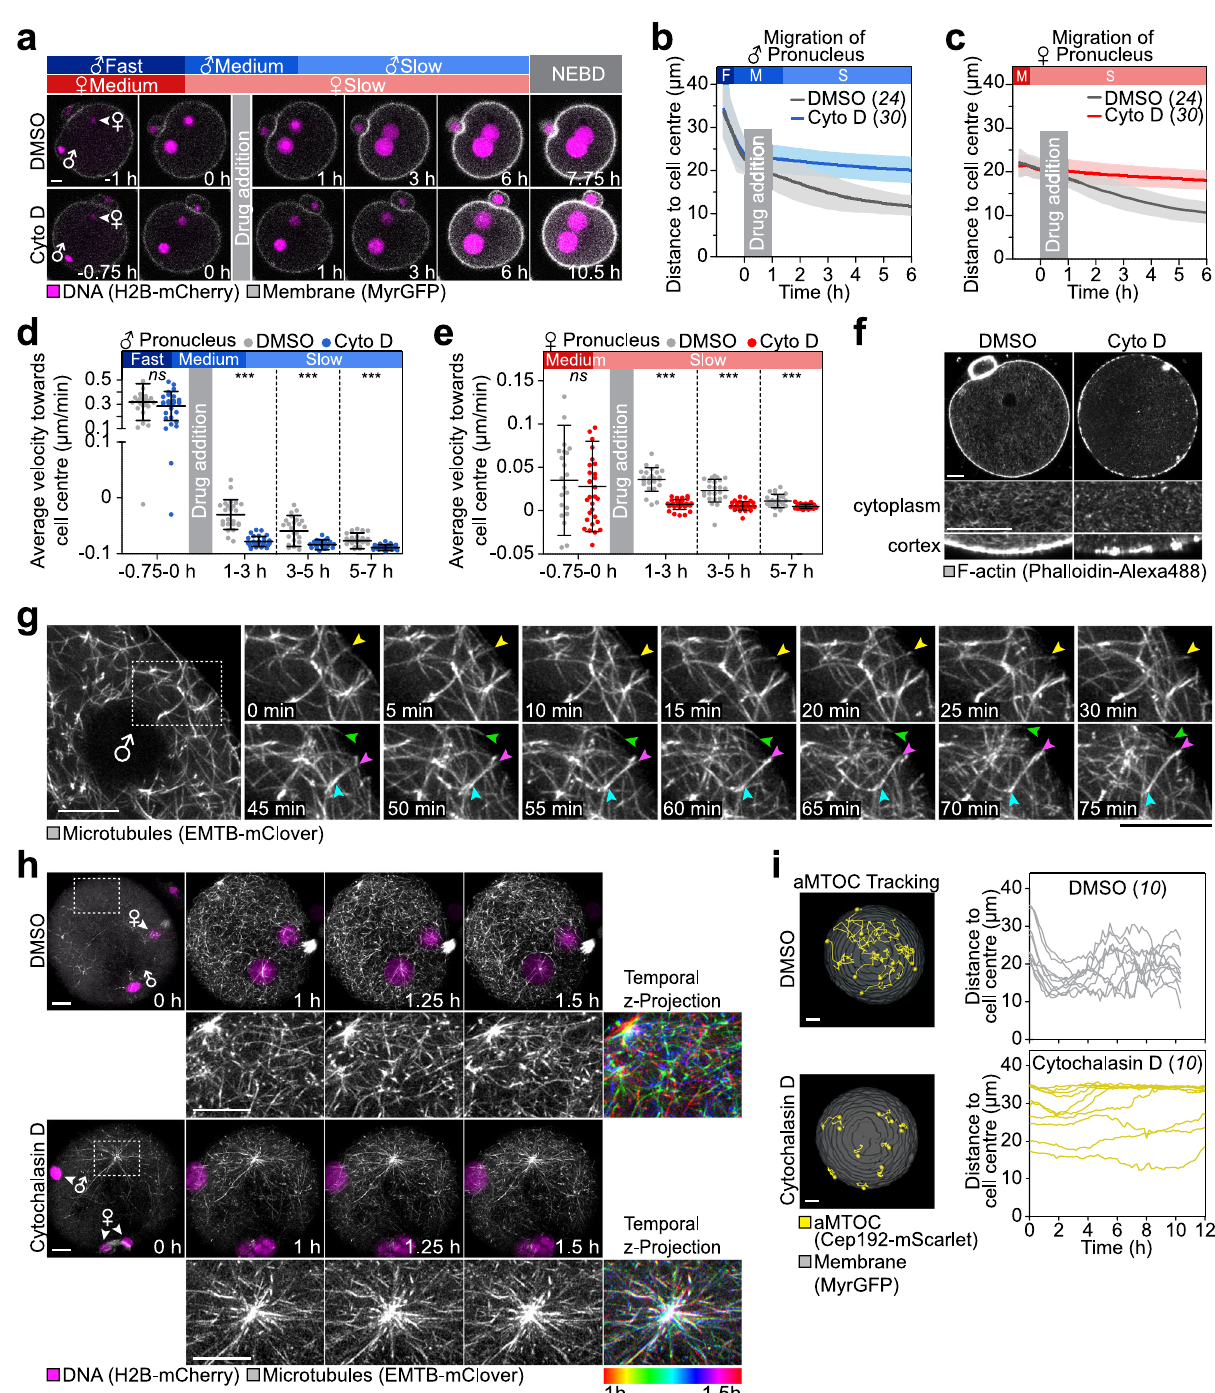
inhibition of the microtubule-dependent pathway (by nocodazole) and the Rab11a-Spire-Fmn2-dependent pathway (by Rab11a S25N ) (Fig. 9a, Supplementary Fig. 10a, b and Supplementary Movie 20) prevented pronuclear migration in 11/27 zygotes (Fig. 9a, bottom panel) and led to an additional signi fi cant increase in the distance of the pronuclei from the zygote ’ s centre at NEBD (by 120 or 80% in comparison to the controls, in male and female pronuclei, respectively (Fig. 9b, c)), despite compression of 10/27 zygotes which caused a decrease in the apparent distance of the pronuclei from the cell centre (Fig. 9a, bottom panel). Simultaneous inhibition of both pathways with cytochalasin D also caused